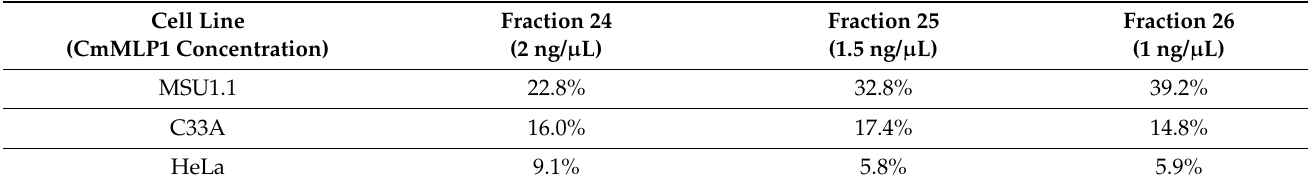
Table 3. Viability of C33A and HeLa cancer cell lines vs. normal MSU1.1 treated with latex fractions containing CmMLP1 accompanied with